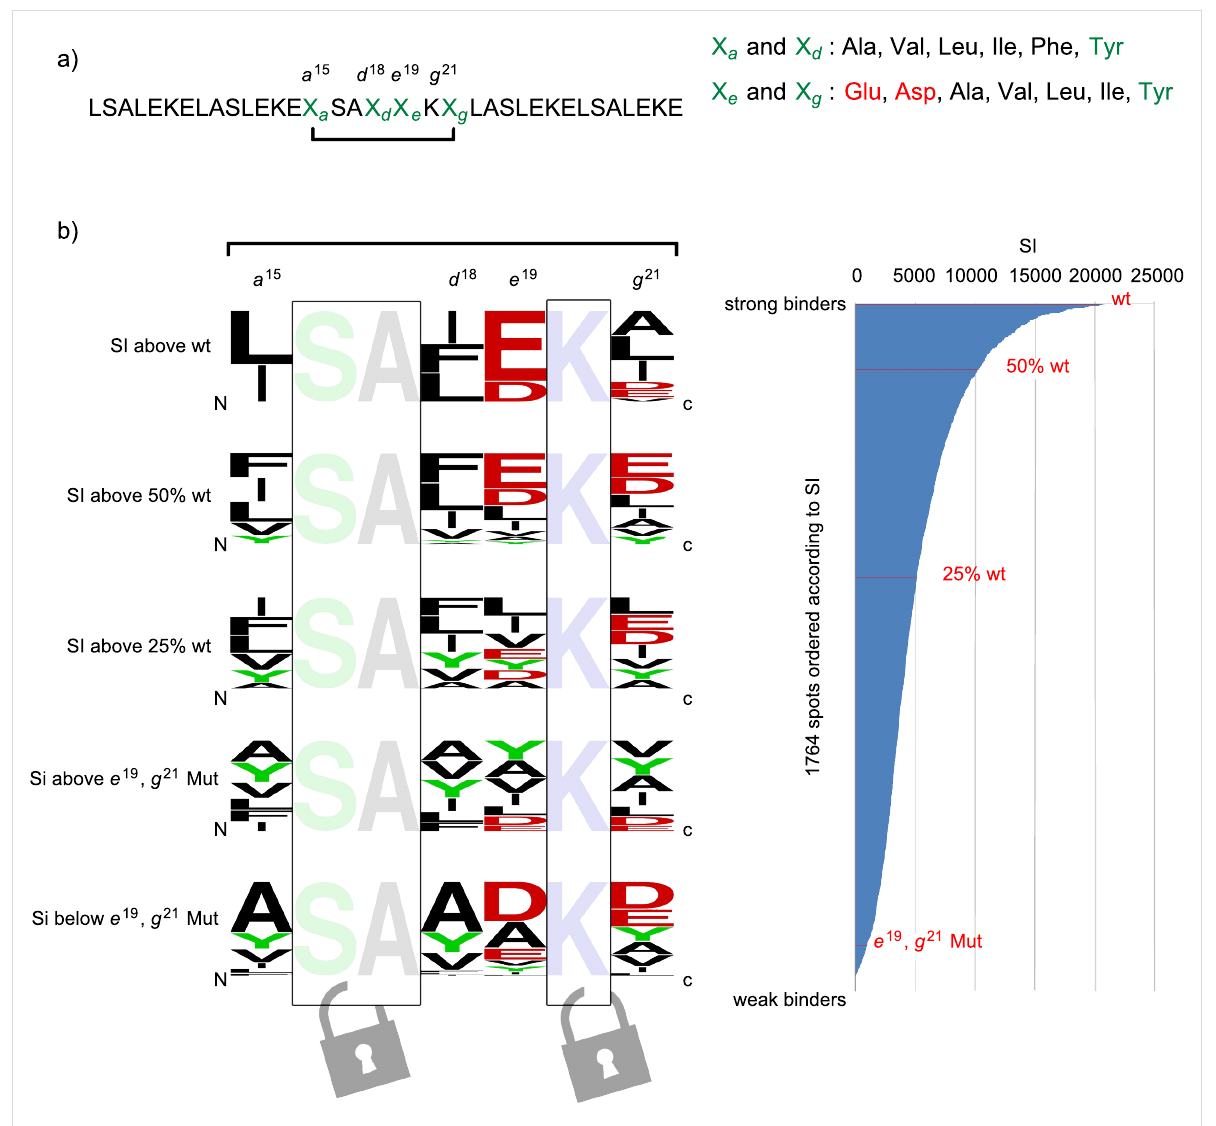
Figure 2: (a) Sequence for random mutation resulting in 1764 spots. The randomized positions are denoted by X a , X d , X e , and X g , and the amino acids selected for randomization are listed on the right. (b) The sequence logos (left) indicate the frequencies of specific a / d / e / g substitutions within a class (the larger the letter, the higher the frequency). The mutated positions a , d , e , and g are denoted by 15, 18, 19, and 21, respectively. The graph (right) displays the signal intensity (SI) of the 1764 spots and is ordered from strong to weak binders. Indicated are the four interaction classes grouped according to SIs relative to the Acid-pp wt SI and the e 19 , g 21 mutant.